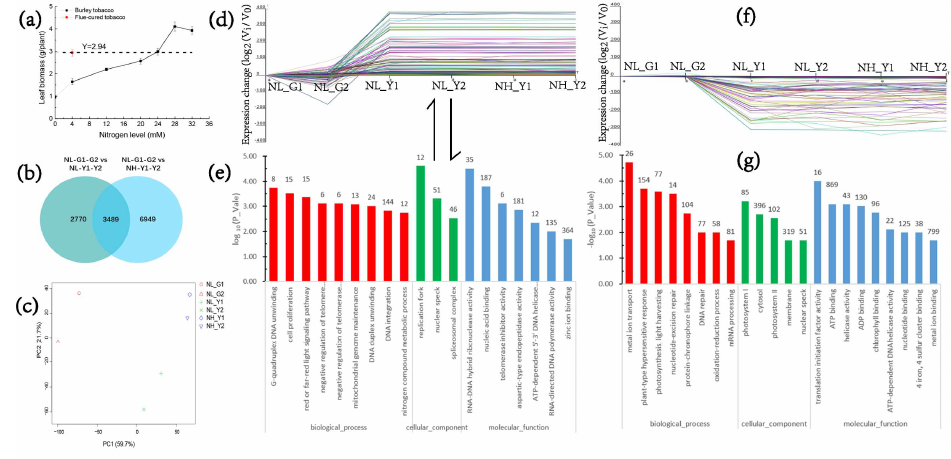
Figure 1. Transcriptome analysis strategies and GO enrichment of target DEGs. ( a ) Leaf biomass in burley tobacco and flue-cured tobacco; ( b ) Venn diagram of DEGs of flue-cured tobacco (NL_G1_G2) vs burley tobacco (NL_Y1_Y2) at the same nitrogen application level and flue-cured tobacco (NL_G1_G2) vs. burley tobacco (NH_Y1_Y2) at the same leaf biomass accumulation condition; ( c ) PCA analysis of treatments; ( d ) Genes represented in Profile 73; ( e ) GO enrichment in Profile 73; ( f ) Genes